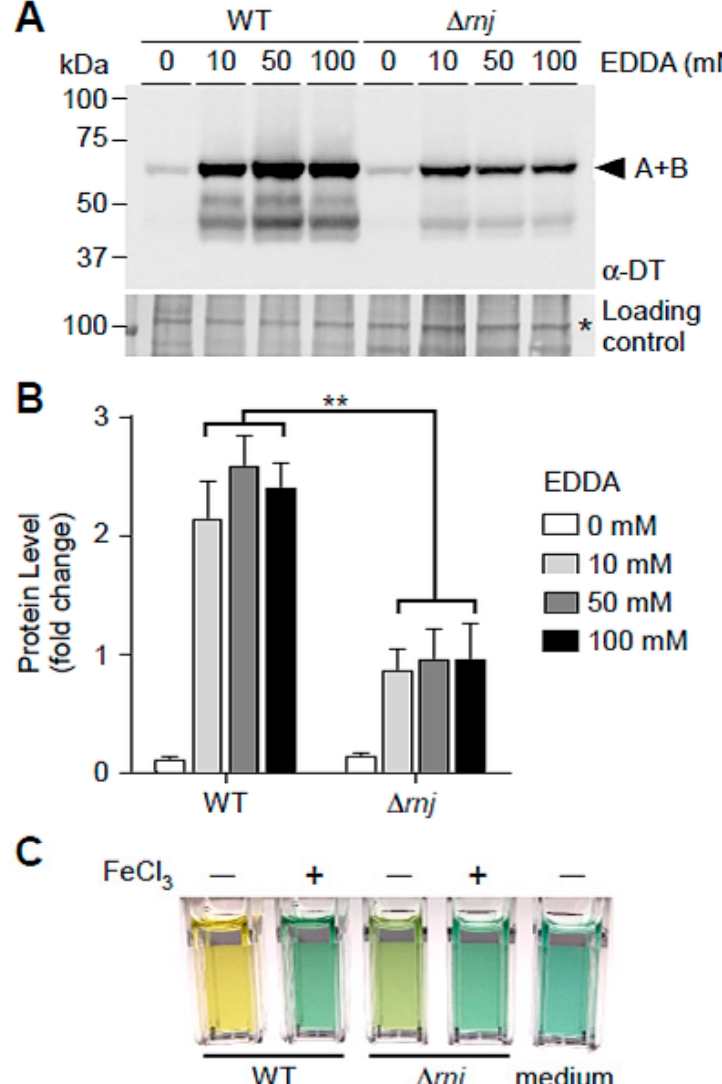
Figure 4. Reduced production of the exotoxin diphtheria toxin in the ∆ rnj mutant. ( A ) Cells of the C. diphtheriae parental strain (WT) or ∆ rnj mutant strain were treated with various concentrations of the iron chelator ethylene diamine diorthohydroxyphenyl acetic acid (EDDA) to induce expression of diphtheria toxin (DT). Harvested supernatants were subjected to TCA precipitation, and protein samples were immunoblotted with monoclonal antibodies against DT; arrowhead indicates the intact toxin. A loading control band from an immunoblotted membrane stained with Coomassie Blue is marked with an asterisk. The results are representative of four independent experiments. ( B ) Density of DT blots in ( A ) was quantified by ImageJ and analyzed using GraphPad Prism 5.0, with ** indicating p < 0.01. ( C ) Bacterial cells were grown in a semi-defined low-iron medium supplemented with 10 µ M FeCl 3 . Production of extracellular siderophore was determined by a colorimetric assay using chrome azurol